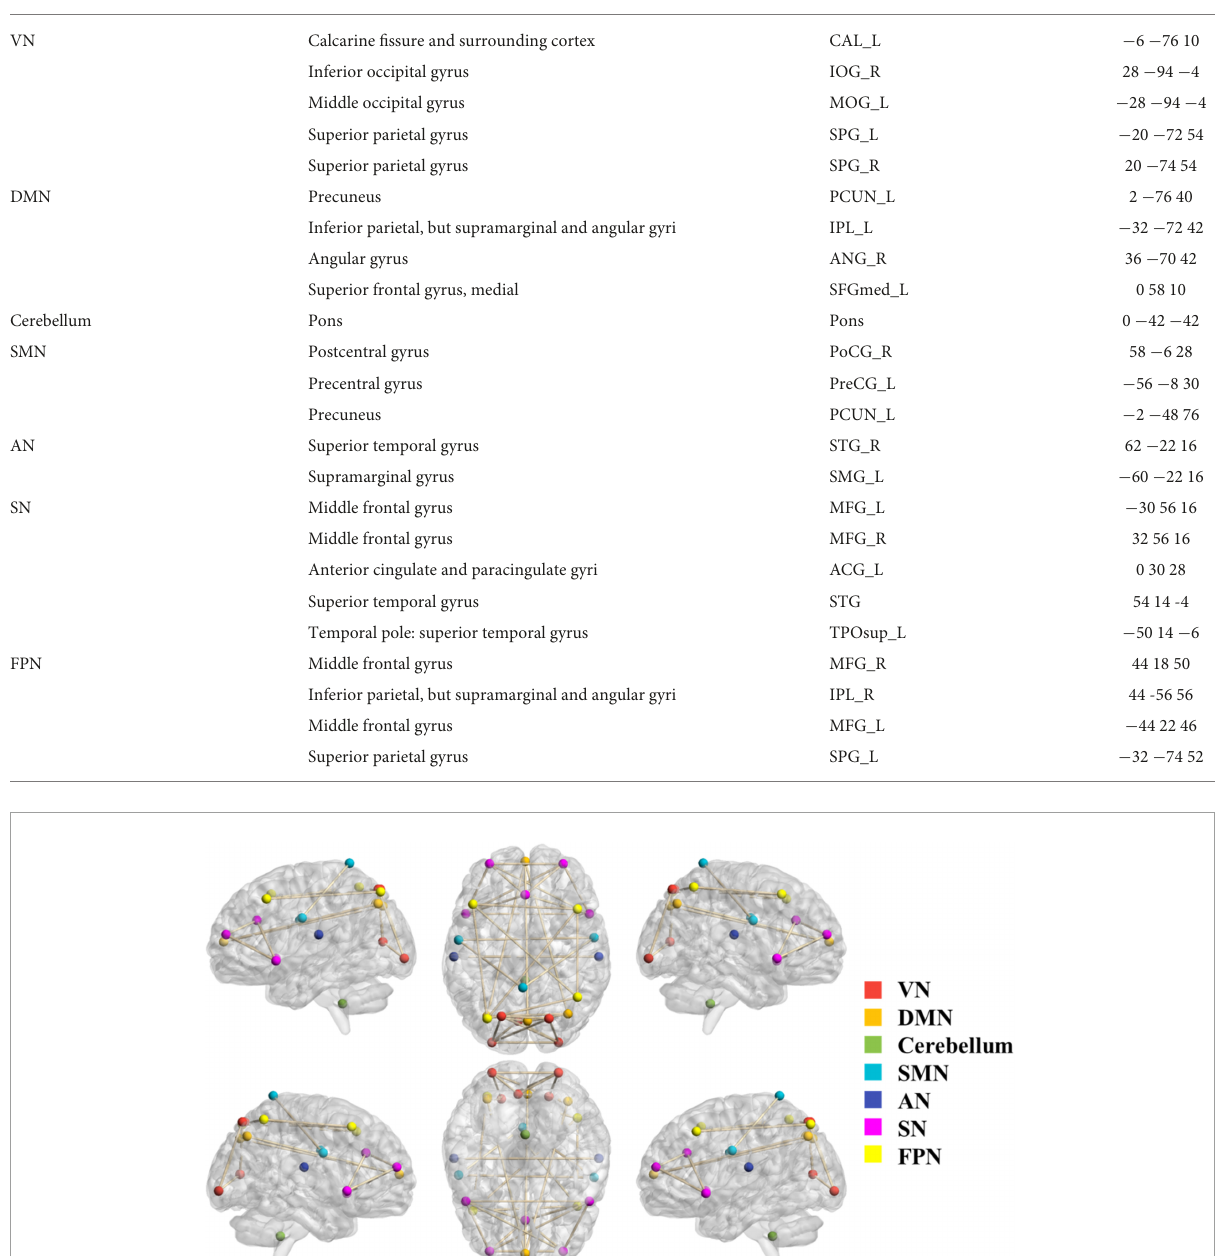
with Figure 3 , each colored circle in the figure indicates that there is an effective connection between the brain regions of the corresponding rows and columns. The size of the colored circle corresponds to the size of the effective connectivity value, and the direction is from the brain region of the corresponding